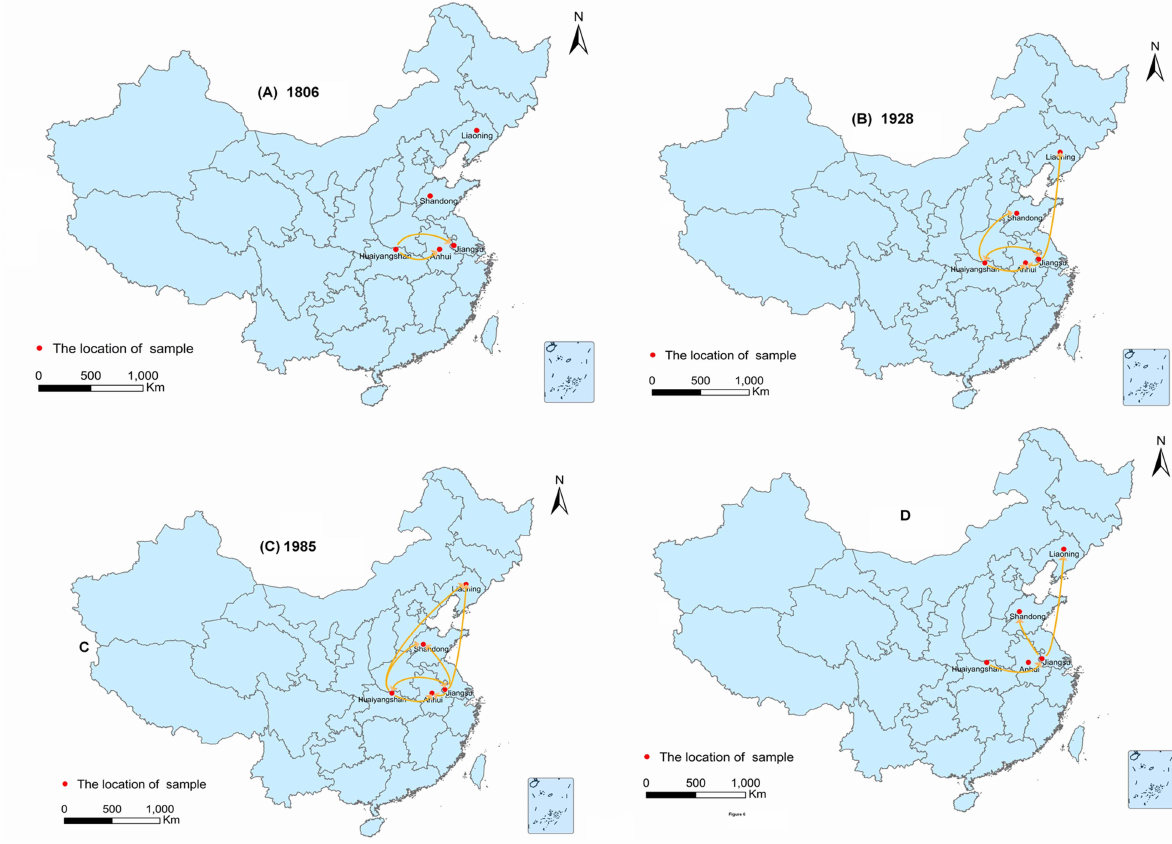
Figure 5. (A–C) Inferred migration graph for FTLSV in China and its reflection of the events reconstructed from the MCC tree for 1806, 1928 and 1985. The maps are based on satellite pictures made available in Google Earth. (D) The FTLSV migration routes inferred under the discrete phylogeographic diffusion model using a BF test. Rates supported by 3 , =BF , 10.